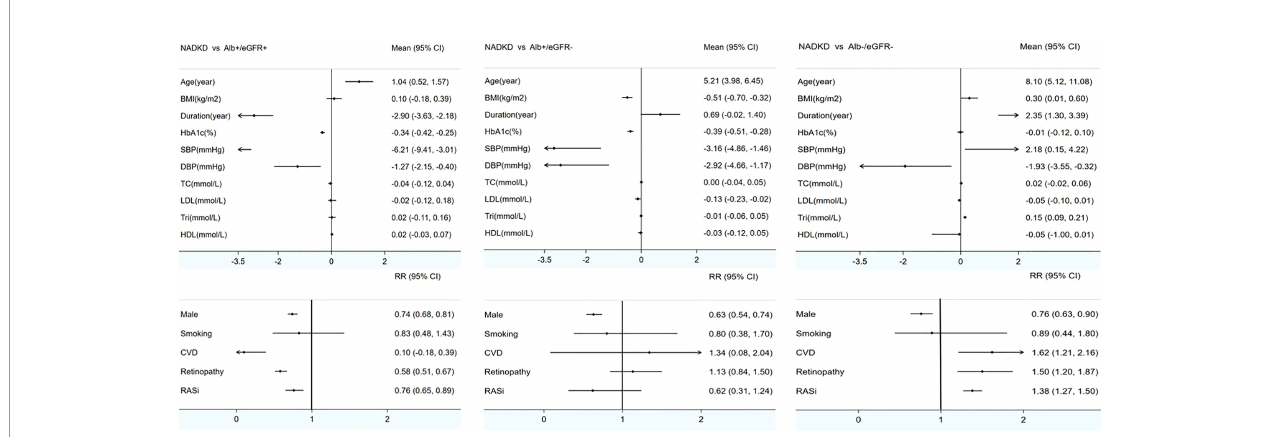
FIGURE 2 | Meta-analyses of clinical characteristics of patients with NADKD compared with patients with Alb + /eGFR - and Alb - /eGFR - BMI indicates body mass index; HbA1c, glycated hemoglobin; Retino, retinopathy; CVD, cardiovascular disease; SBP, systolic blood pressure; DBP, diastolic blood pressure; TC, total cholesterol; LDL, low-density lipoprotein; Tri, triglyceride; HDL, high-density lipoprotein; RASi, renin – angiotensin system inhibitor; NADKD, normoalbuminuria diabetic kidney disease; Alb+/eGFR+, albuminuria diabetic kidney disease with renal insuf fi ciency; Alb+/eGFR-, albuminuria diabetic kidney disease without renal insuf fi ciency; Alb-/eGFR-, nonalbuminuria diabetic kidney disease without renal insuf fi ciency; Mean, mean difference; RR, risk ratio. Renal insuf fi ciency (GFR < 60 ml/min/1.73 m 2